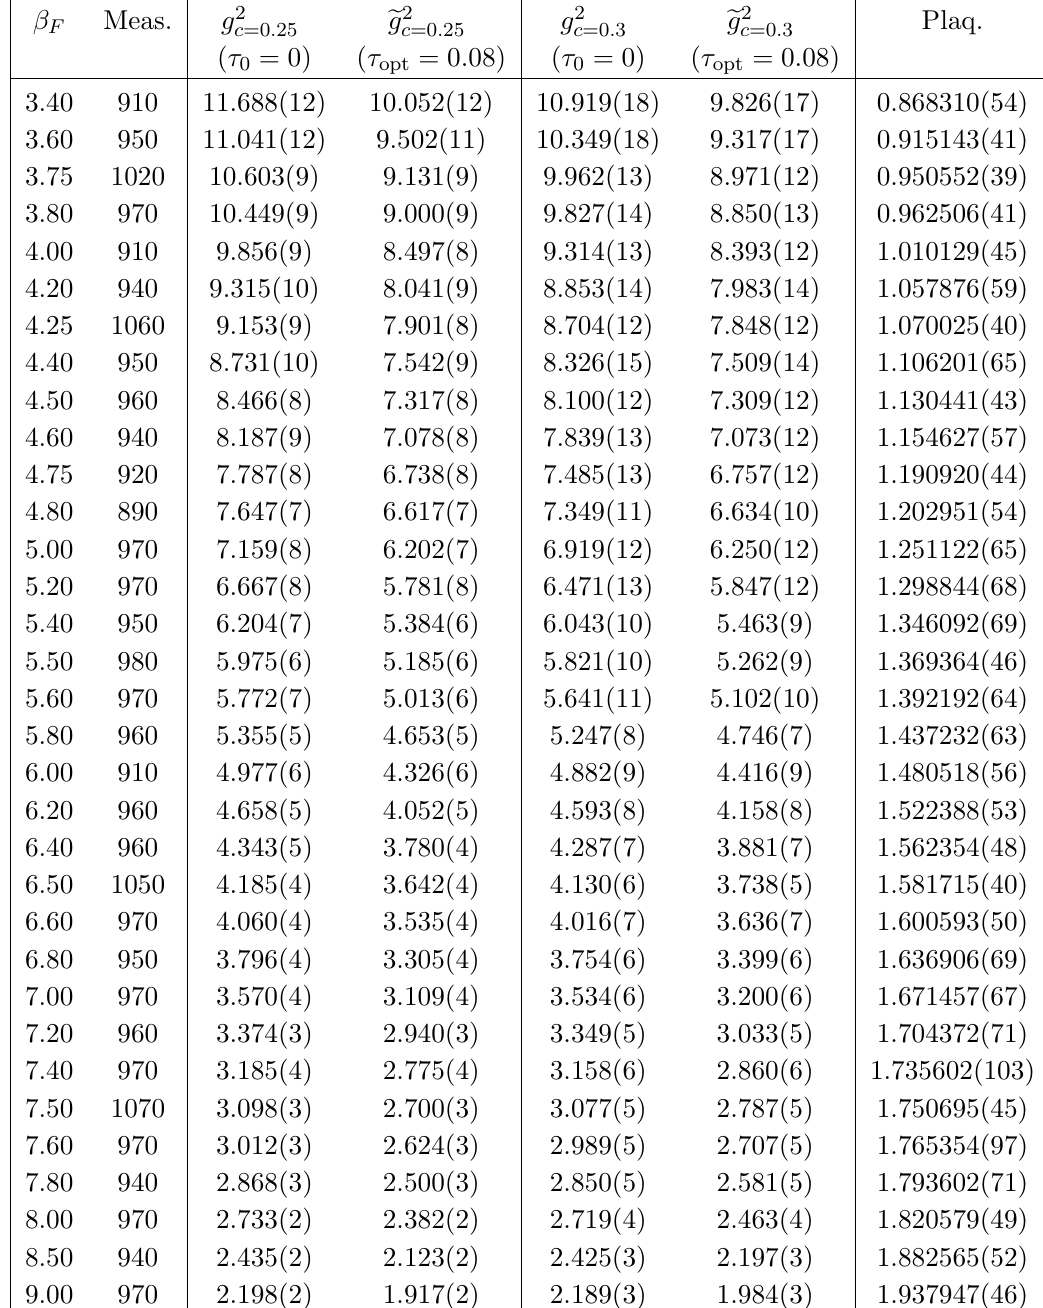
Table 3 . 12 4 lattice ensembles used in this work. For each bare coupling (cid:12) F we report the renor- malized gradient (cid:13)ow couplings for the clover discretization of E ( t ) at two values of c = 0 : 25 and 0.3 with both (cid:28) 0 = 0 and the optimal (cid:28) opt = 0 : 08, all obtained from the given number of thermalized measurements. The thermalized measurements are separated by ten molecular dynamics time units (MDTU) generated with the HMC algorithm, and combined into ten-measurement (100-MDTU) jackknife blocks to reduce autocorrelations. We also list the average plaquette (normalized to 3), to illustrate the roughness of the gauge (cid:12)elds.